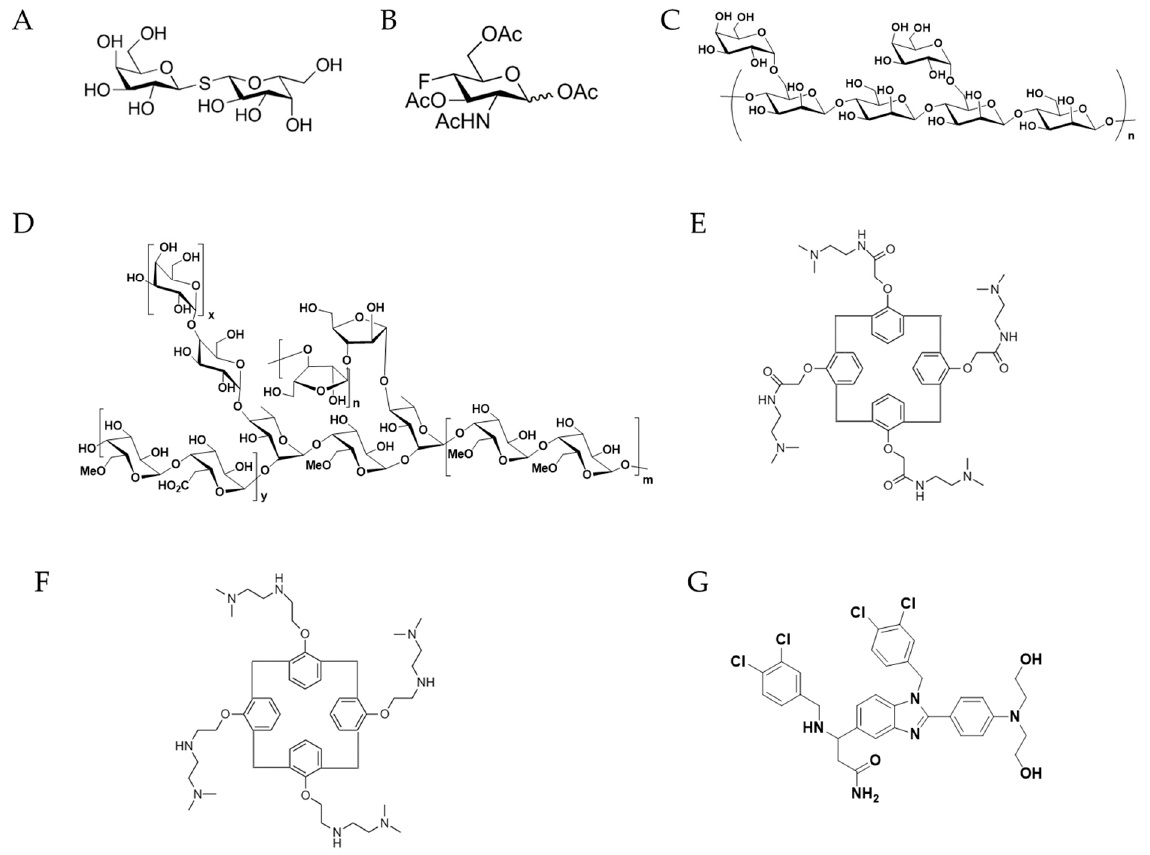
Figure 2. Chemical structures of Gal-1 inhibitors. ( A ) Thiodigalactoside. ( B ) 4-F-GlcNAc. ( C ) GM-CT-01. ( D ) GR-MD-02. ( E ) OTXOO8. ( F ) PTX013. ( G ) LLS30.